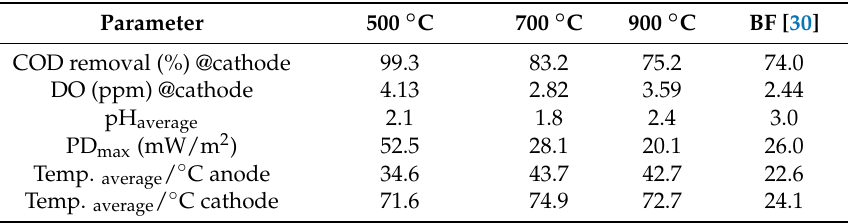
Table 3. Performance of system @ calcination conditions of Fe 2 O 3